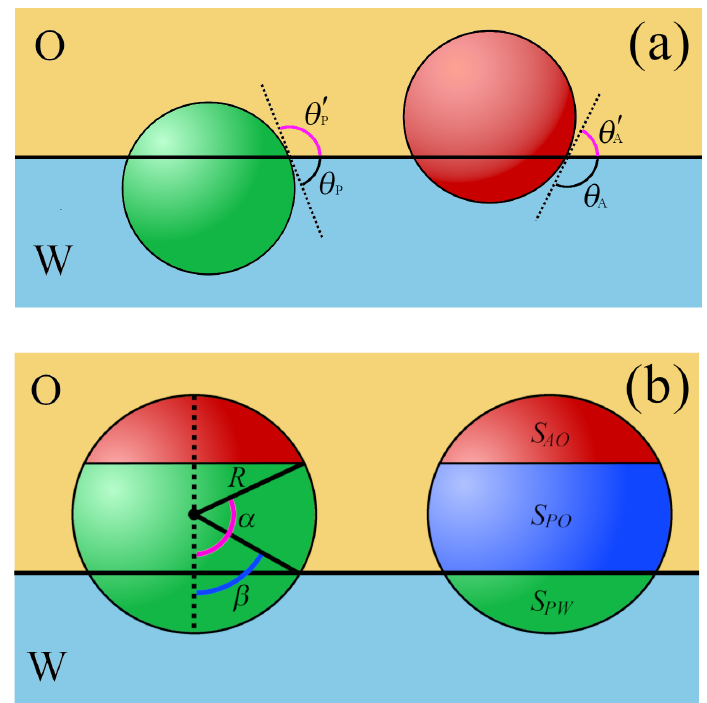
Figure 2. Spherical particles at a fluid/fluid interface (O/W). ( a ) The contact angles of homogeneous polar, θ P , and apolar, θ A , particles. ( b ) The left part: the geometry of a Janus particle: the relative areas of the polar (green) and apolar (red) particle patches are characterized by angle α and the contact angle of the Janus particle at interface β . The right part: areas of different particle–fluid interfaces, S PW for a polar region in contact with the fluid W (green), S PO for a polar region in contact with the fluid O (navy), and S AW for an apolar region in contact with the fluid O (red). Then, from the Young equation, we